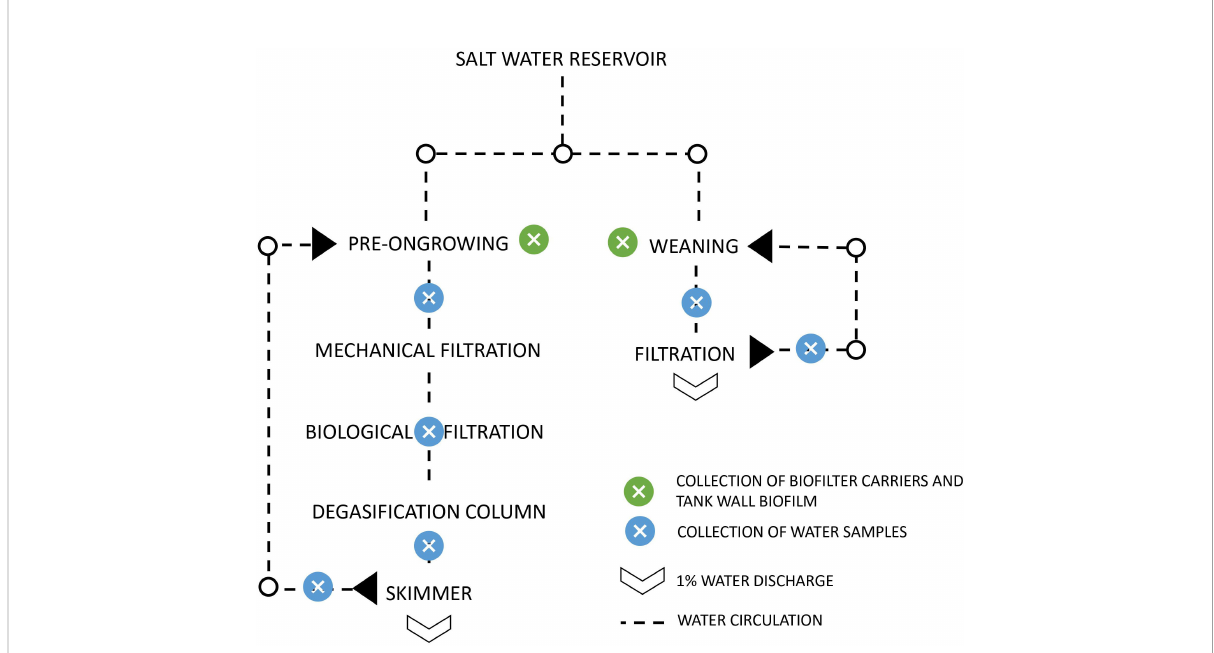
FIGURE 1 Representation of the aquaculture unit in study. The pre-ongrowing and weaning operate with water